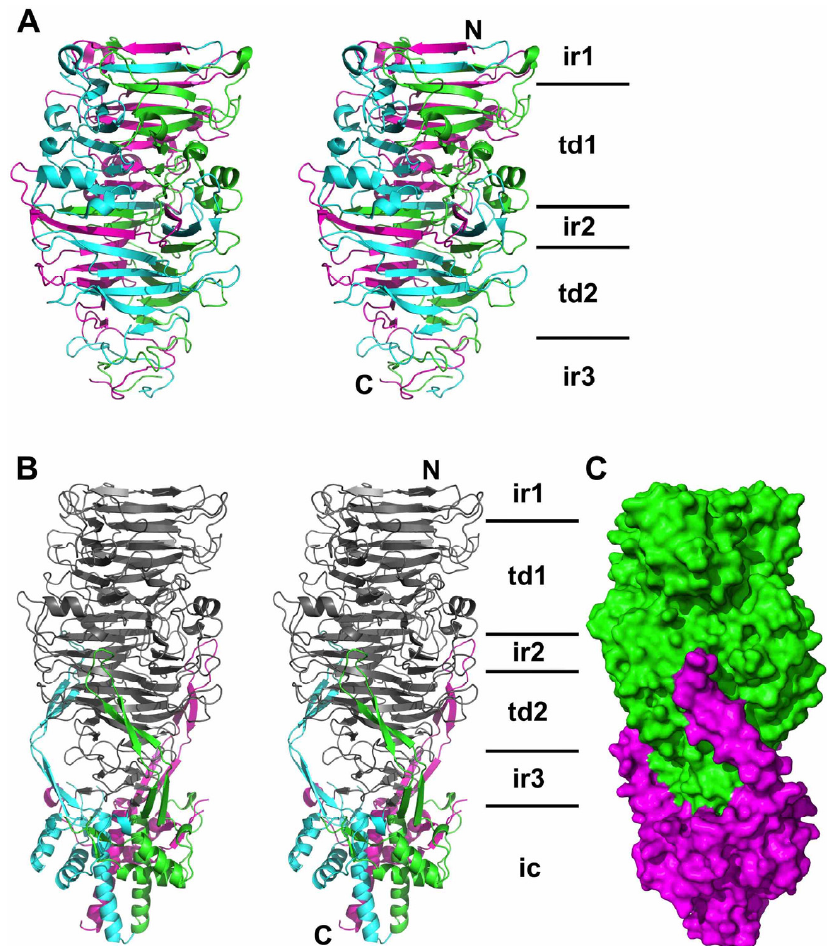
Figure 2. Structure of the carboxy-terminal domain of the bacteriophage T5 L-shaped tail fibre. ( A ) Overall side stereo-view of pb1(970–1263) in cartoon representation. Monomers are coloured differently (chain A green, chain B blue, chain C magenta). The first interdigitated region (ir1), first triangular domain (td1), second interdigitated region (ir2), second triangular domain (td2) and third interdigitated region (ir3) are indicated (interdigitated regions and triangular domains have been described in phage tailspike structures before, see text). The amino-terminal (N) and carboxy-terminal ends of the magenta subunits are indicated; ( B ) Overall side stereo-view of pb1(970–1396) in the same orientation as part A. Pb1(970–1263) is shown in gray, the monomers of the intra-molecular chaperone domain (ic) coloured differently (chain A green, chain B blue, chain C magenta); ( C ) Space-filling diagram in the same orientation as in part B. The carboxy-terminal part of the protein is coloured green, the intra-molecular chaperone domain in magenta.